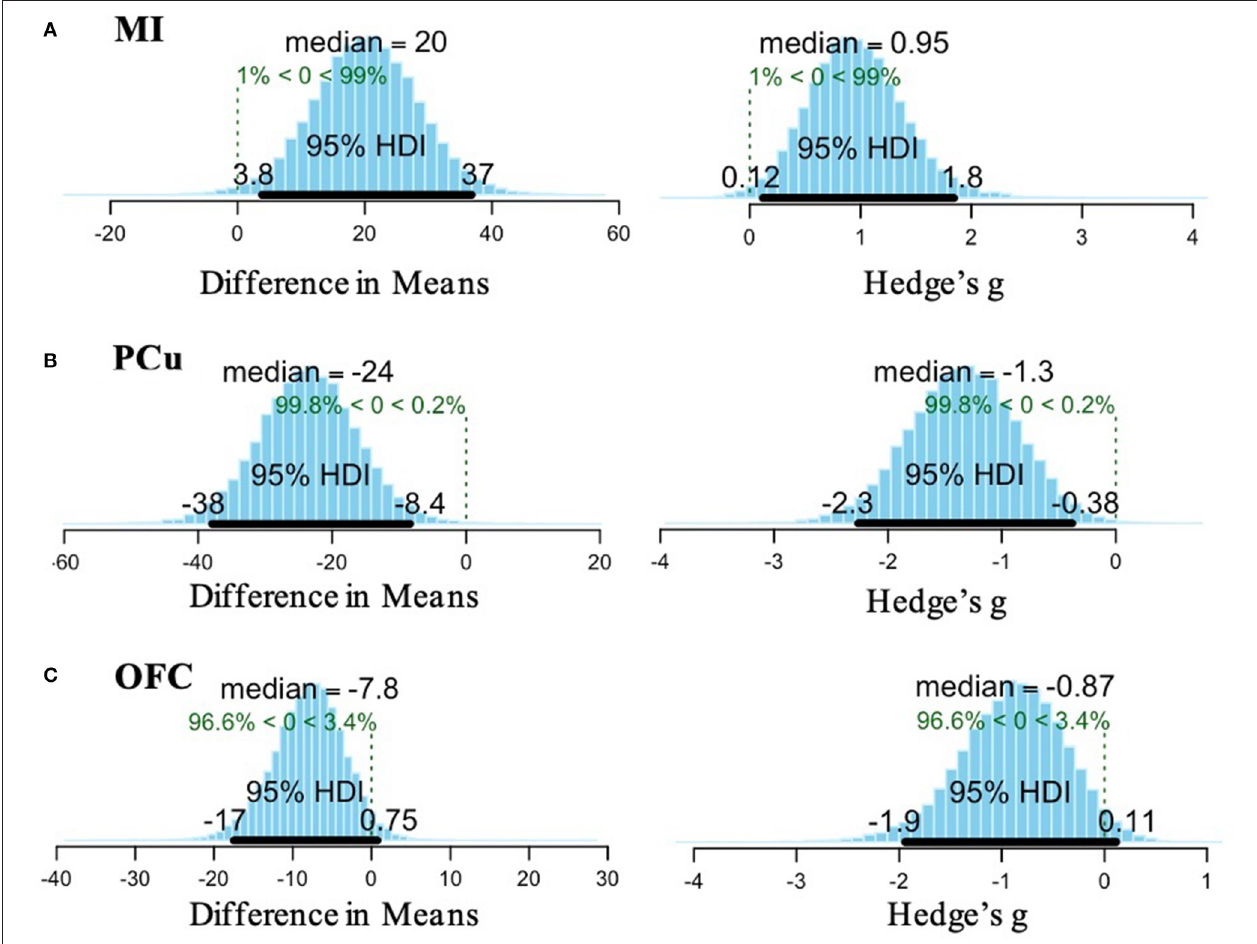
FIGURE 3 | Bayesian analysis results for (A) MI, (B) PCu, and (C) OFC. (A) Posterior distribution for the difference in means of MI activation between OCD and TDC indicates a 99% probability of the observed effect (left). The effect size (computed as Hedge’s g ) of the difference in means is 0.95 and the 95% high density interval (HDI) indicates the range of 95% of the most credible values for the effect size is 0.12–1.8 (right). (B) Posterior distribution for the difference in means of PCu activation between OCD and TDC indicates a 99.8% probability of the observed effect (left). The effect size is − 1.3 and the 95% HDI indicates that 95% of the most credible values for the effect size fall between − 2.3 and − 0.38 (right). (C) Posterior distribution for the difference in means of OFC activation between OCD and TDC indicates a 96.6% probability of the observed effect (left). The effect size is − 0.87 and the 95% HDI crosses zero [ − 1.9 to 0.11], so there is less confidence in the stability of this result